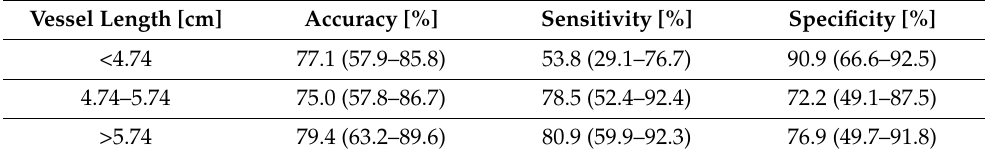
Table 11. Diagnostic performance and 95% CI of the model as a function of the OCT sequence length. Vessel Length